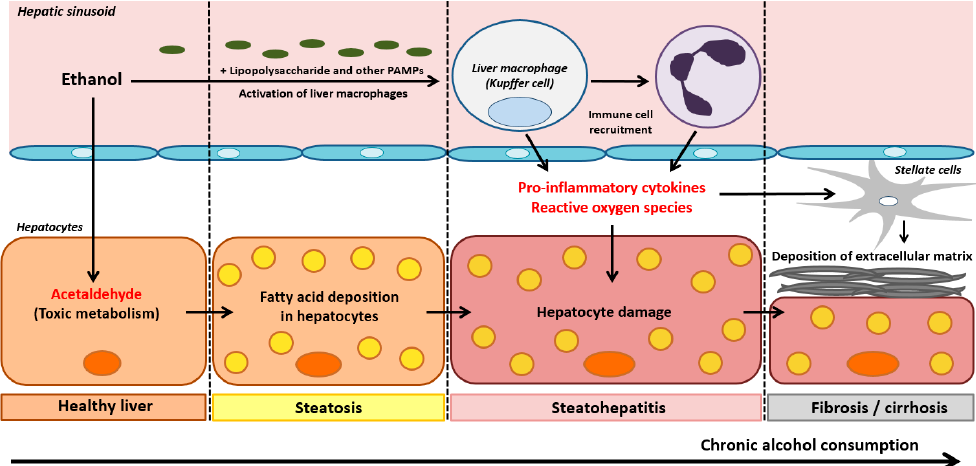
Figure 3. Pathophysiological mechanisms of the three stages in ALD: hepatic steatosis, steatohepatitis, and fibrosis/cirrhosis. PAMPs: Pathogen-associated molecular patterns.